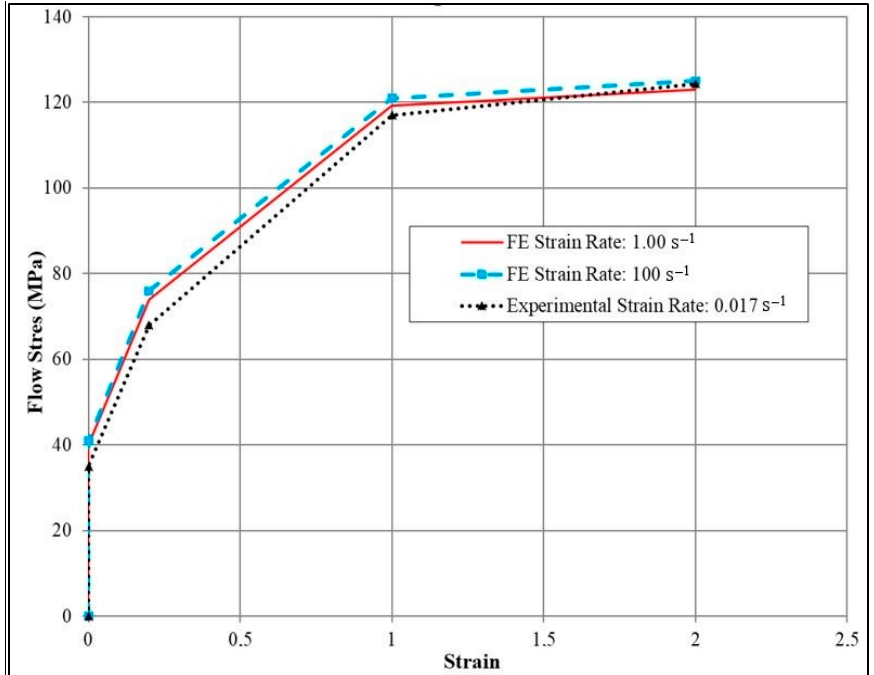
Figure 7. Flow stress–strain curve of Al 1100.